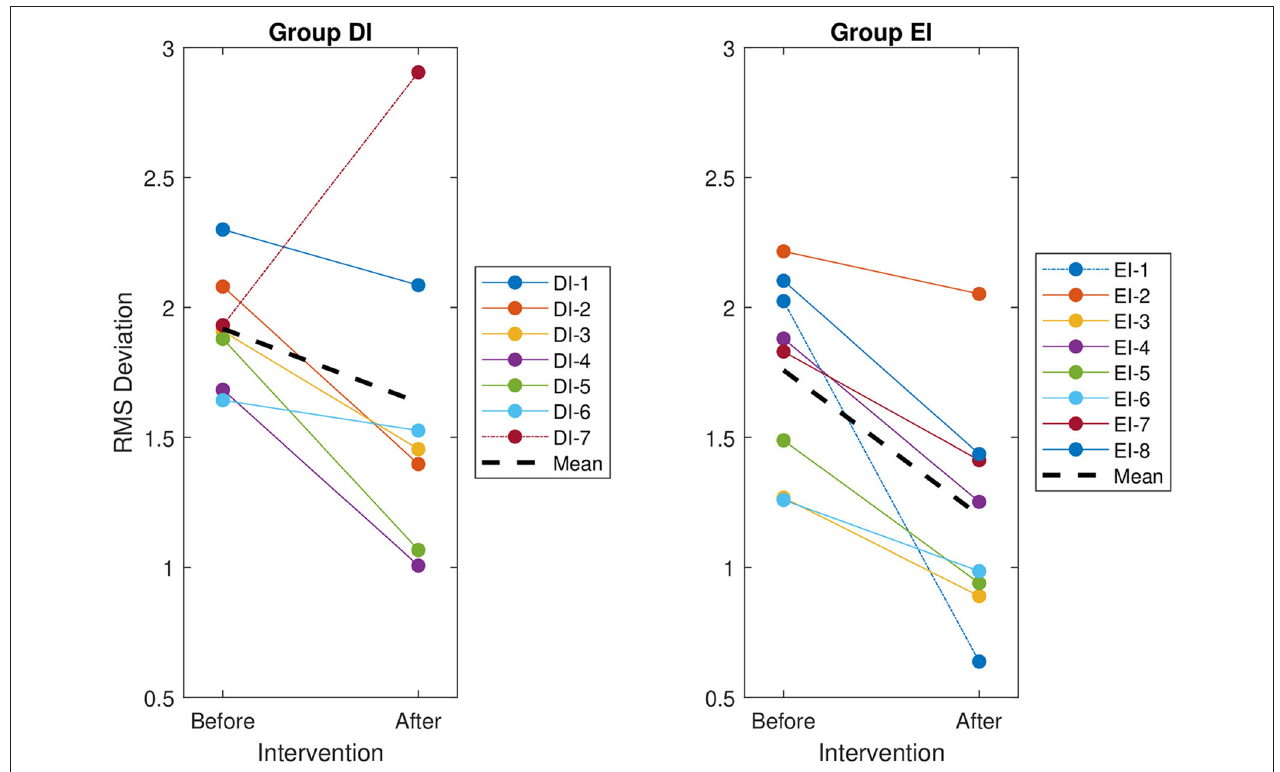
FIGURE 5 | The root mean square (RMS) deviation of each reviewer’s evaluations from the group mean, before and after the intervention. The RMS deviation for each reviewer is indicated by a solid line. The overall RMS deviation for each group is indicated by a thick dashed line. The identified special cases, indicated by a dot-dashed line, are DI-7 for Group DI—the only reviewer to deviate more from the group after the intervention—and EI-1 for Group EI—the only reviewer to improve visibly more than the other reviewers in the group.